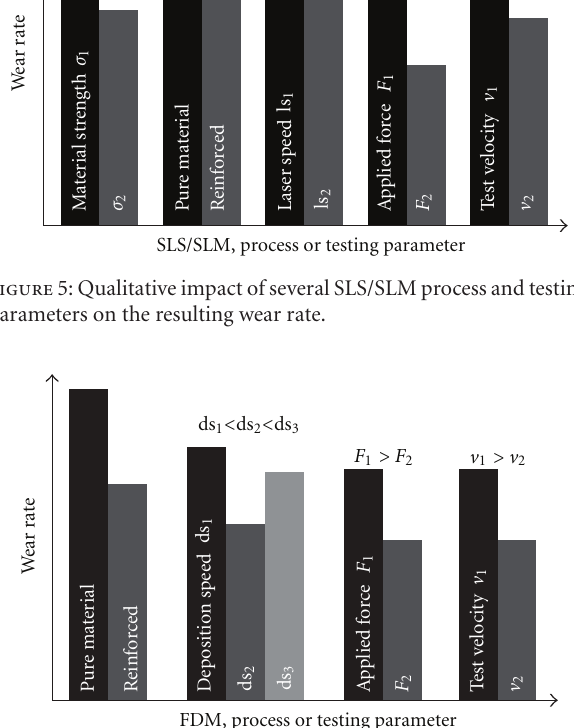
Figure 6: Qualitative impact of several FDM process and testing parameters on the resulting wear